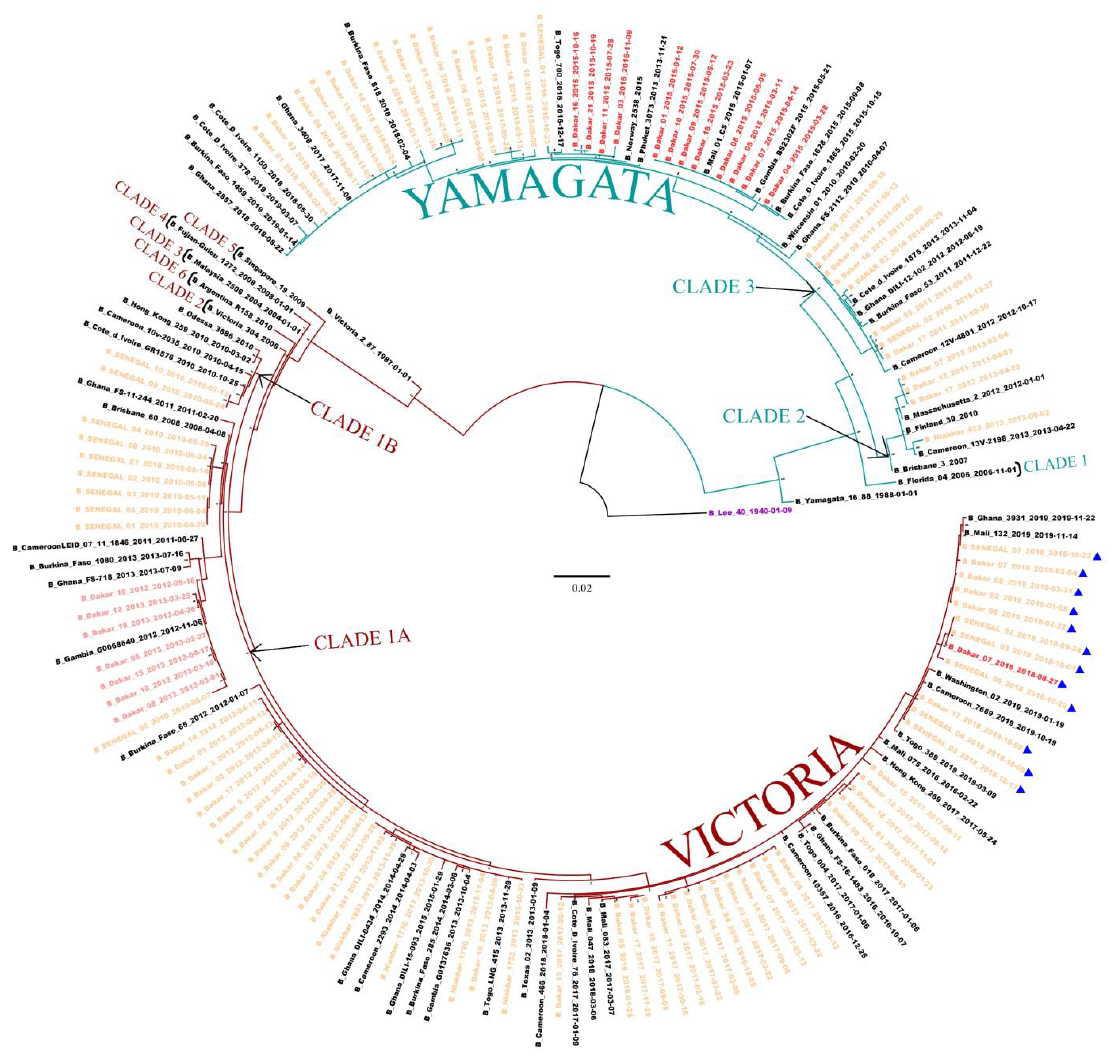
Figure 2. The maximum likelihood (ML) tree for the HA gene of IBV circulating in Senegal. ML tree was calculated using the IQ-TREE software version 1.6.12 [18] and visualized using the Figtree software version 1.4.4 [19]. A bootstrap number of 1000 was used, and the software was responsible for defining the correct model used. Strain B/Lee/1940 was used in order to root the tree (purple). Senegalese strains, inter-lineage recombinant strains, and intra-lineage recombinant stains are respec- tively indicated in orange, red and pink. Strains with ∆ 162–164 in the HA gene (D162, K163, N164) are also indicated ( (cid:78) ).